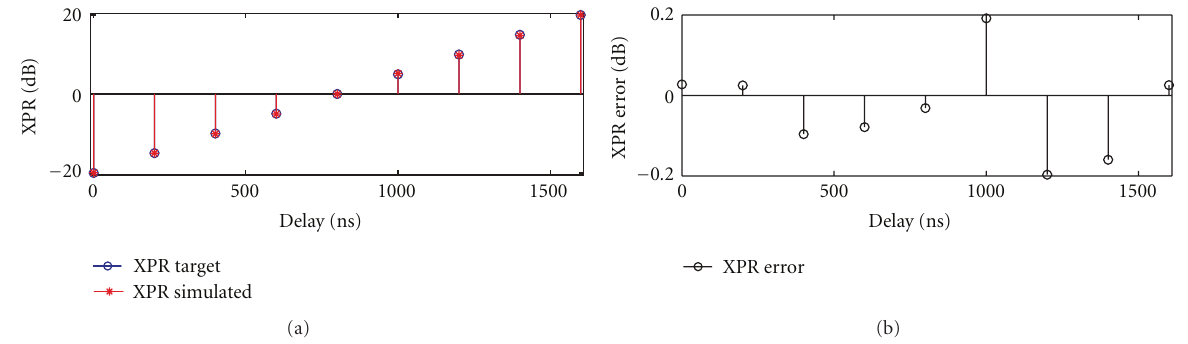
Figure 7: Simulated XPR with prefaded signals synthesis, target XPR is from − 20 to +20dB with 5dB increments.